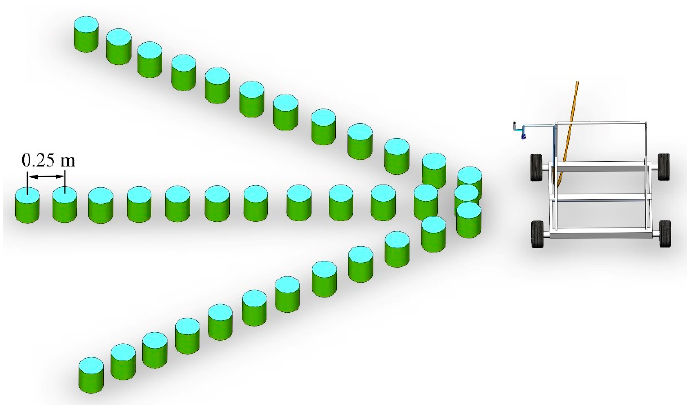
Figure 4. The test layout of radial distribution of sprinkler intensity and impact kinetic energy intensity .